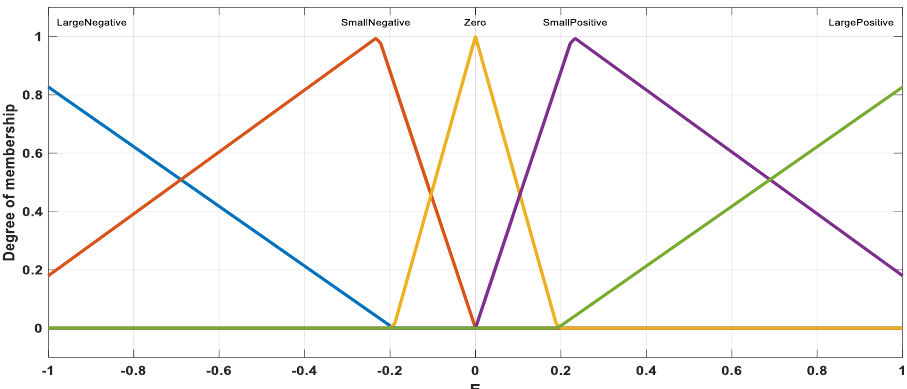
Figure 5. The MPA optimizer’s ULC-fuzzy PID controller block diagram.